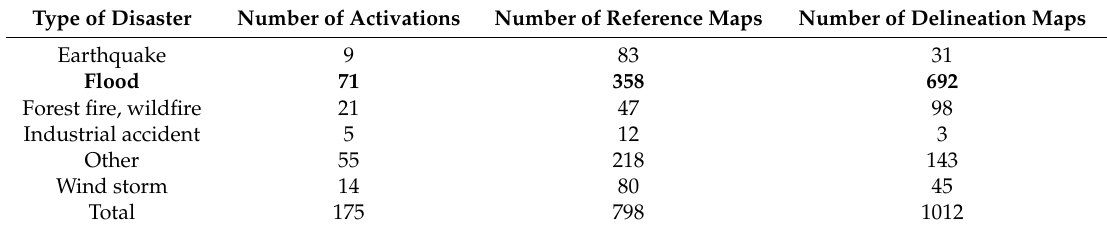
Table 8. Summary of the Copernicus Emergency Management Service (EMS)-Mapping